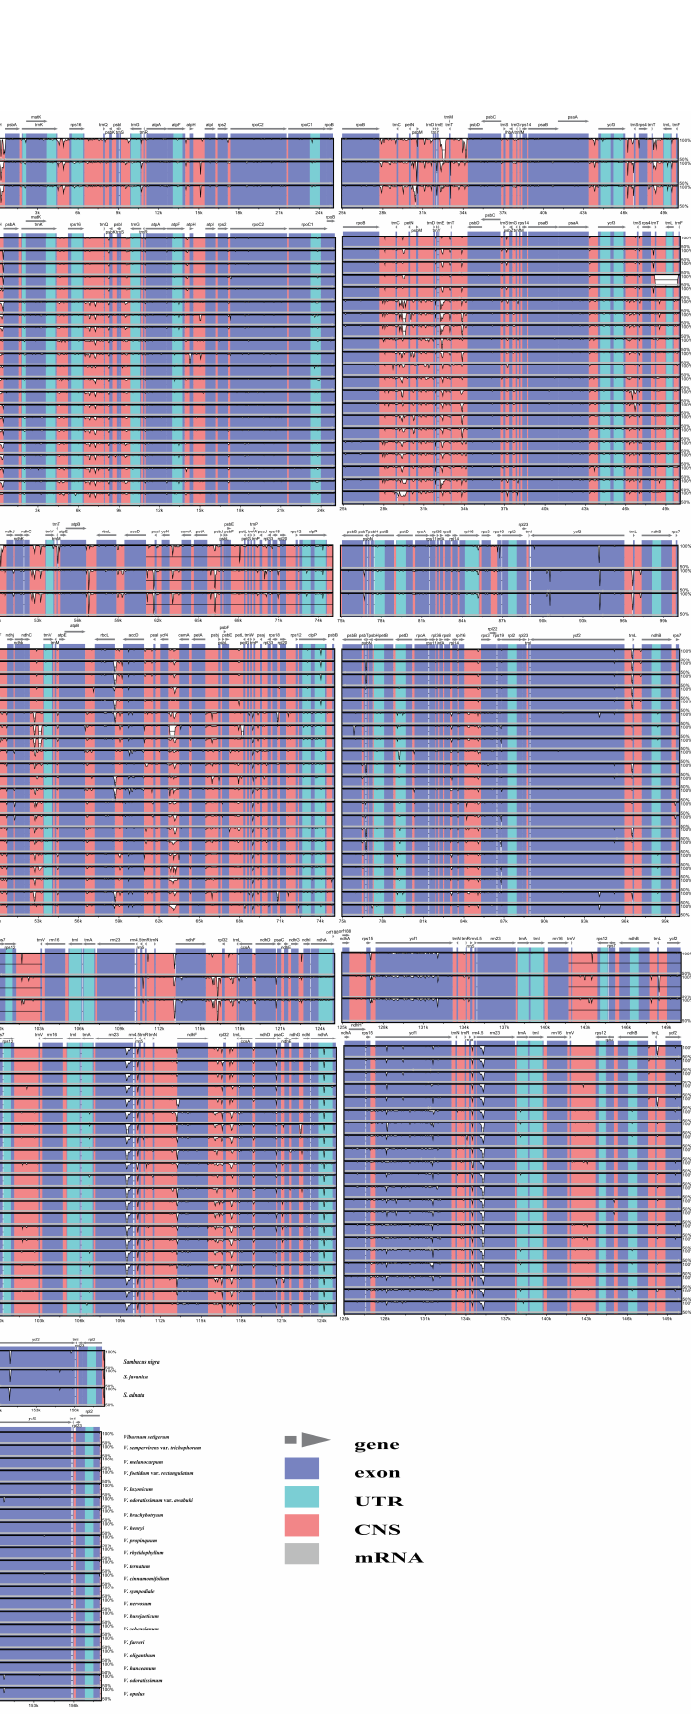
Figure A1. Sequence identity plots among 24 Adoxaceae chloroplast genomes.